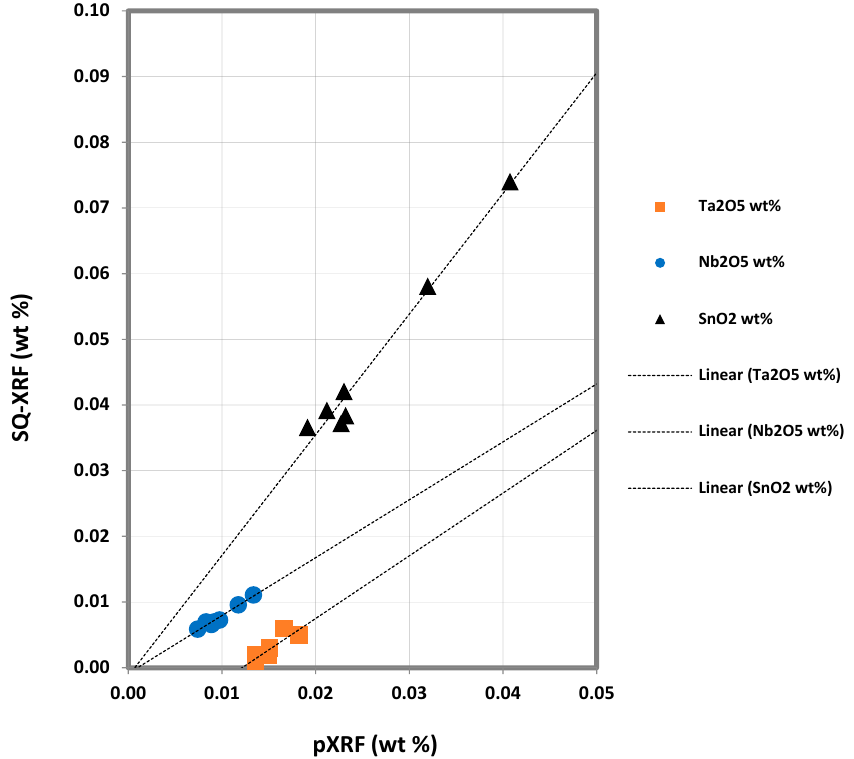
Figure 15. Scatter plot showing correlation of results from PXRF and SQ-XRF analysis of Knelson Concentrator products for for Ta, Nb and Sn.